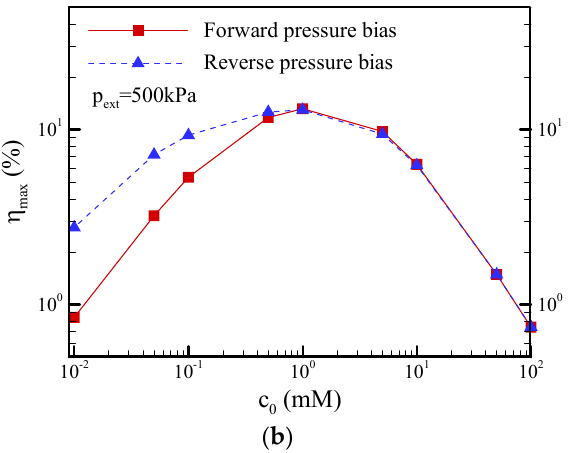
Figure 13. Plots of the ( a ) maximum power density (P max /A m ) and ( b ) maximum conversion efficiency ( η max ) as a function of the salt concentration under a pressure bias of p ext = 500 kPa. Note θ = 1.2°, σ s = −5 mC/m 2 , and b = 20 nm.